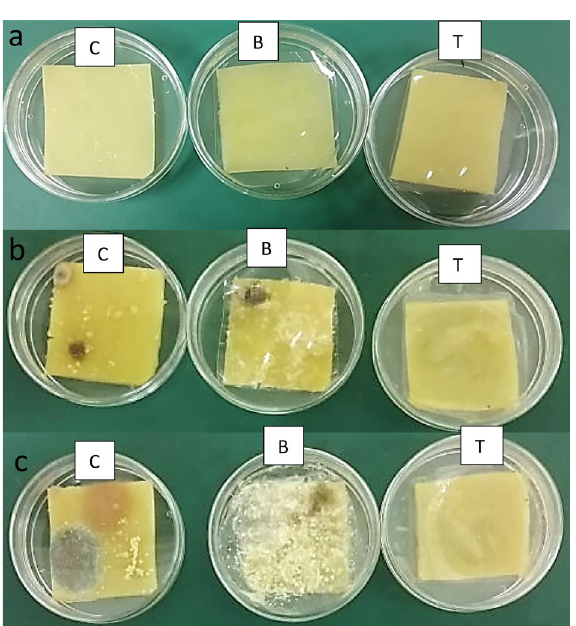
Figure 6. Development of visual spoilage on the cheese surface of (C) control uncovered cheese, (B) cheese covered with film (A), and (T) cheese covered with film (A1). ( a ) Zero time, ( b ) after 2 weeks, and ( c ) after 4 weeks of refrigerated